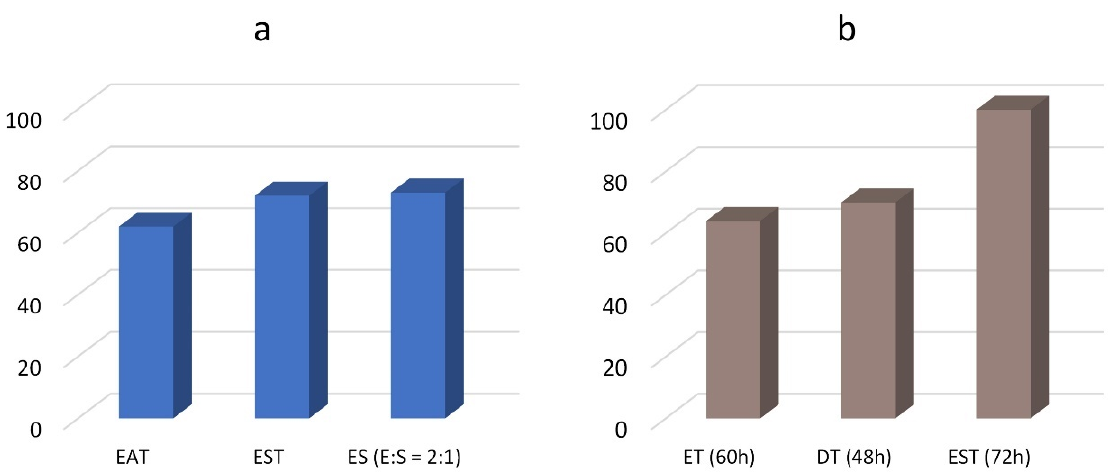
Table 3. Synthesis of oligoamides: equations to calculate the number of repeating units of the oligoamide using the 1 H NMR integral values. 1. Figure 2. Oligoamide yield (%) for different monomers after different reaction times ( a ) 24 h; ( b ) ≥ 48 h at 80 °C.